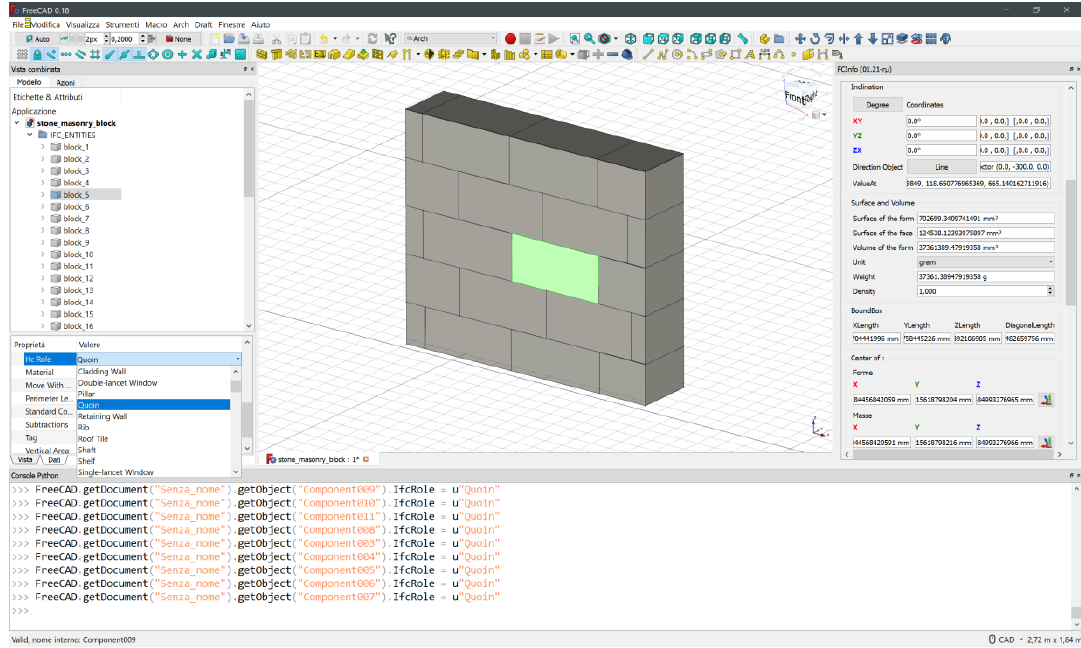
Figure 11. Detail of a medieval stone wall: possible IFC classification of stone quoins through the implementation of FreeCAD ArchComponent.py and managed as construction blocks (components).